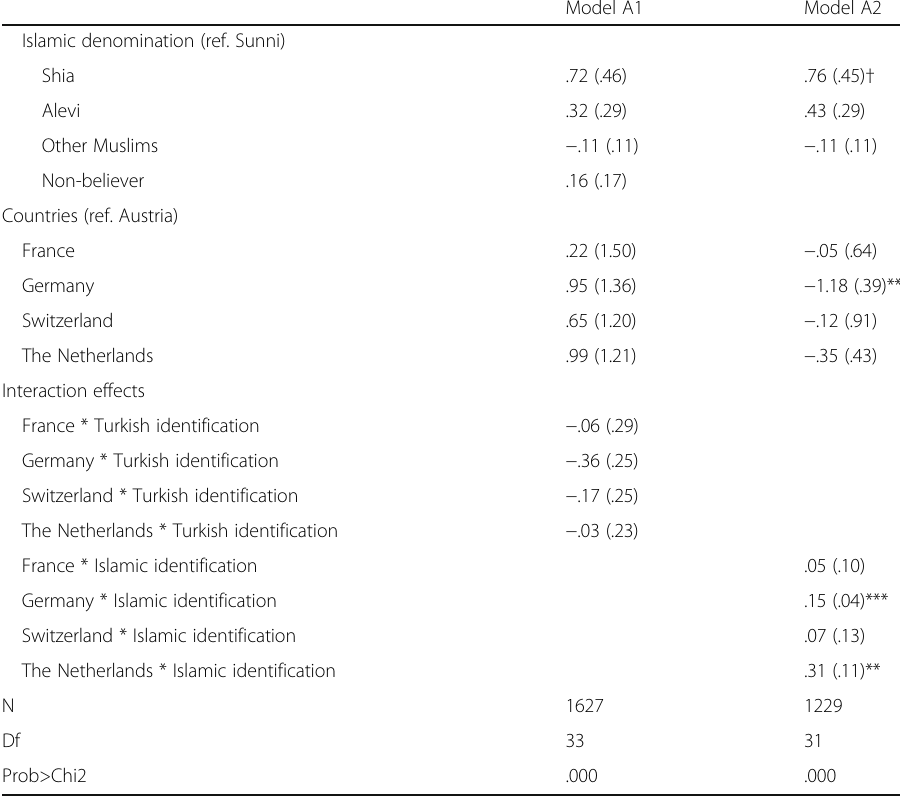
Table 9 Binary logistic regression: Interplay between social identifications, country contexts and